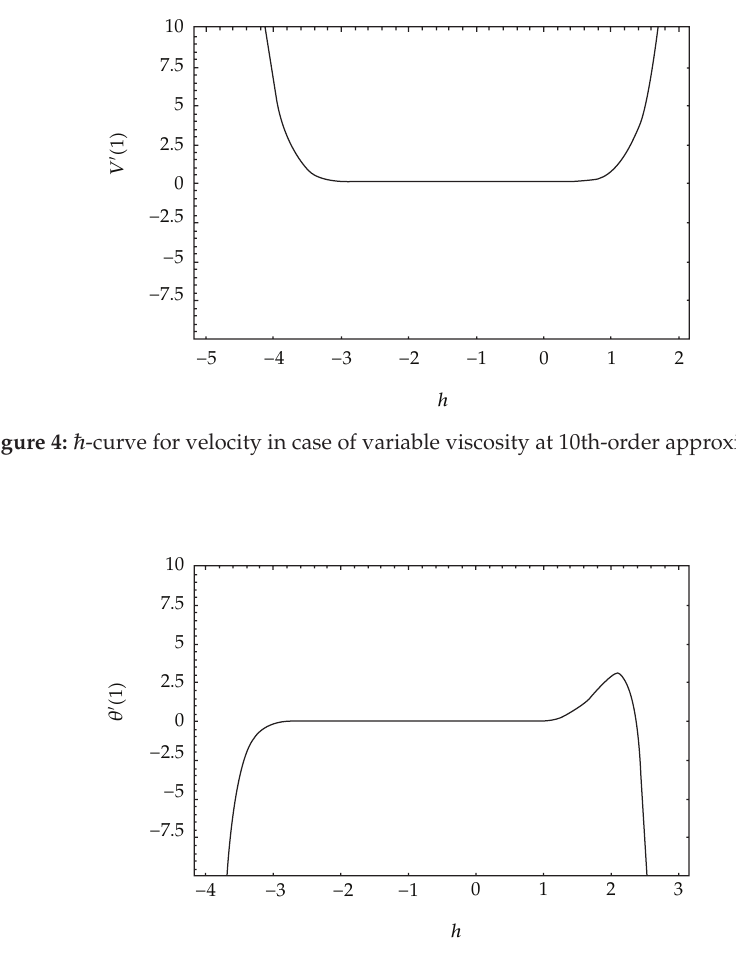
Figure 5: ħ -curve for temperature in case of variable viscosity at 10th-order approximation.